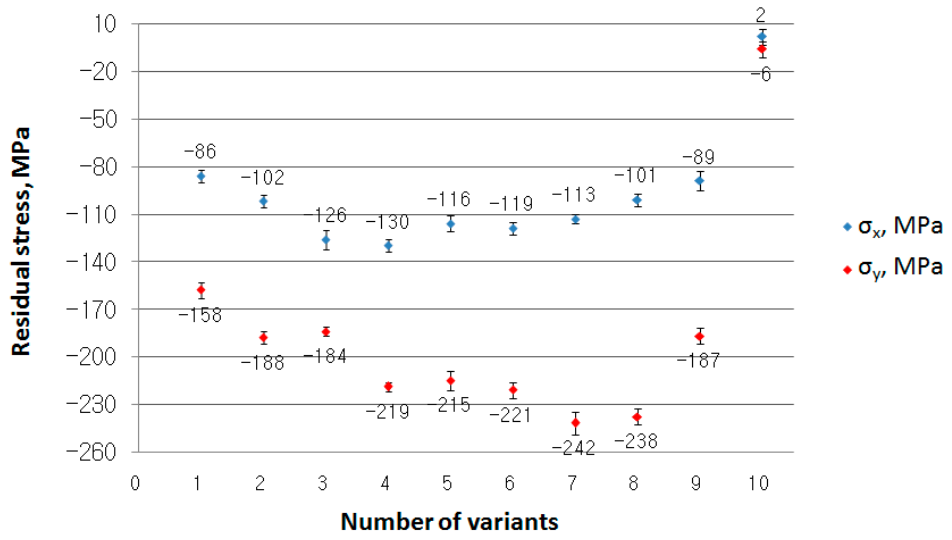
Figure 3. Residual stress of the EN AW-2024-T3 butt welded joints after SDB. Table 4. The results of residual stresses according to PS/DC 3 2 . For stresses in the transverse direction, at feed rates of 𝑓 = 500 mm/min and 𝑓 = 1000 mm/min , an increase in contact force causes an initial increase in compressive stress by 51.16% at a feed rate of 𝑓 = 500 mm/min and 13.75% at a feed rate of 𝑓 = No. 1000 mm/min , and next decrease in compressive stress(Figure 4a). In the case of a 𝑓 = 1500 mm/min , the highest value of compressive stresses was recorded at a burnishing force of 𝑃 = 40 N . In this case, a further increase in the burnishing force causes only a decrease in the stress value. In the case of stresses in the longitudinal direction, the opposite trend can be observed. At the feed rate of 𝑓 = 500 mm/min and 𝑓 = 1000 mm/min , the increase in the tool clamping force causes an increase in the value of compressive stresses. In the case of the feed rate of 𝑓 = 500 mm/min , as a result of changing the force from 𝑃 = 40 N to 𝑃 = 60 N , the compressive stress increased by 53.16% (to 𝜎 (cid:3052) = −242 MPa ), while at the feed rate of 𝑓 = 1000 mm/min by 26.59% to the value of 𝜎 (cid:3052) = −238 MPa ). At the feed rate 𝑓 = 1500 mm/min , the increase in force from 𝑃 = 40 N to 𝑃 = 50 N initially results in an increase in the compressive stress value by 20.10% to 𝜎 (cid:3052) = −221 MPa , and then with the increase in force, a decrease in the stress value by 13.38% (Figure 4b).